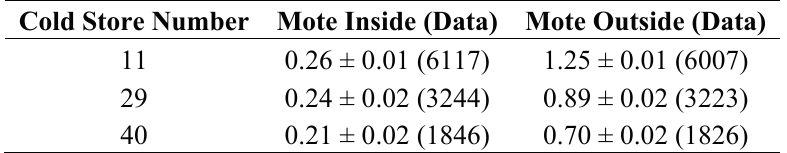
Table 3. Percentage of data lost packets and standard error during the experiments.